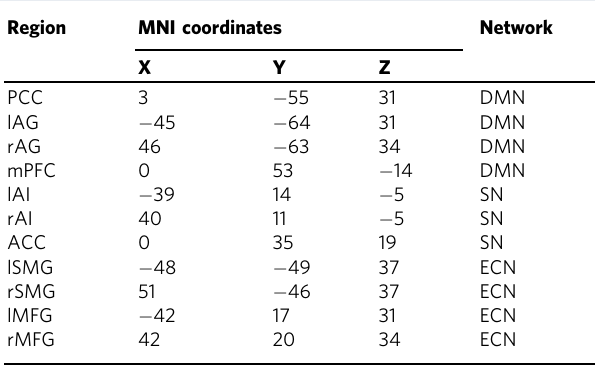
Table 2 Group level volume of interest